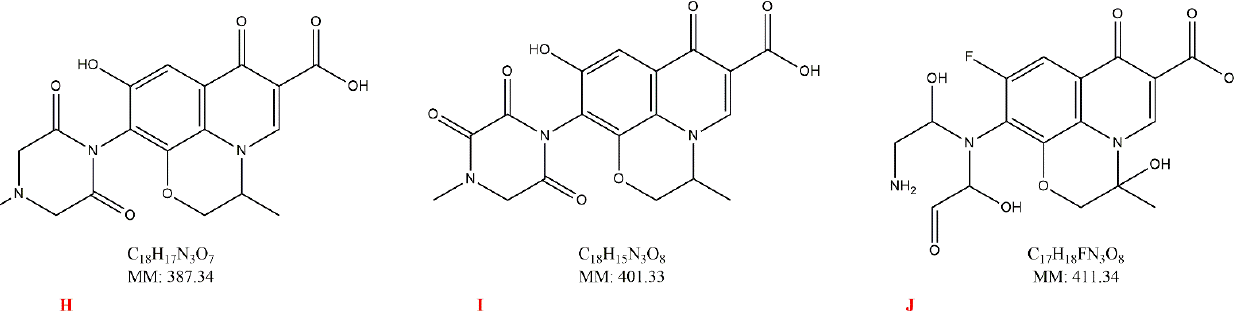
Figure 6. Evolution of the photoproducts with masses in the range 380–413 m/z by irradiation of BT catalyzed OFL. Blue curve: 60 min irradiation, red curve: 90 min irradiation.